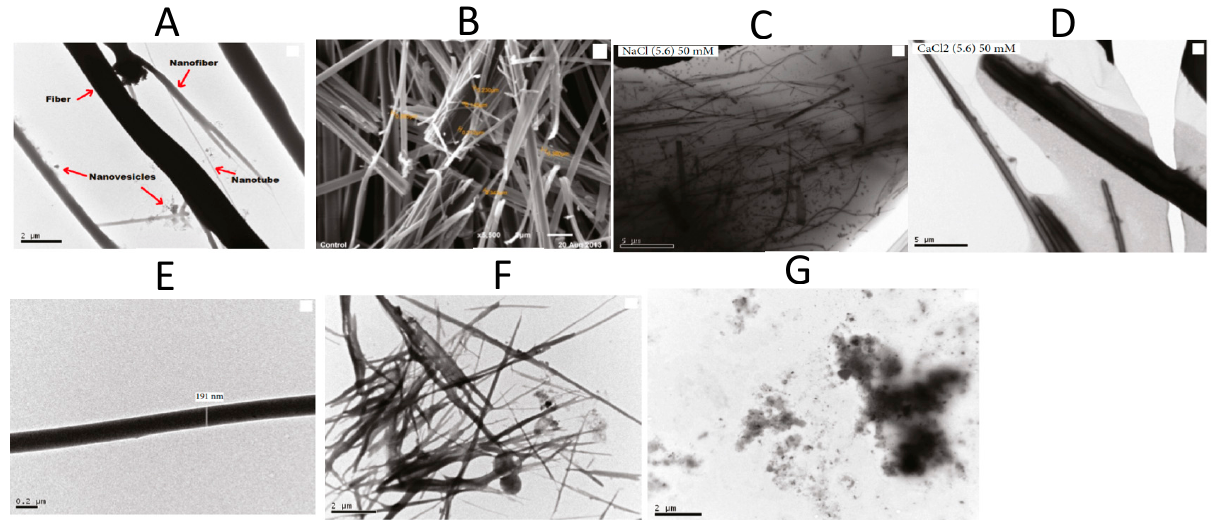
Figure 6. Microscopy images of FF nanostructures. TEM ( A ) and SEM ( B ) in water (control sample). TEM in 50 mM NaCl ( C ) and 50 mM CaCl 2 ( D ) at pH 5.6. TEM at pH = 3 ( E ), pH = 5 ( F ), and pH = 10 ( G ). Adapted with permission from Reference [26].